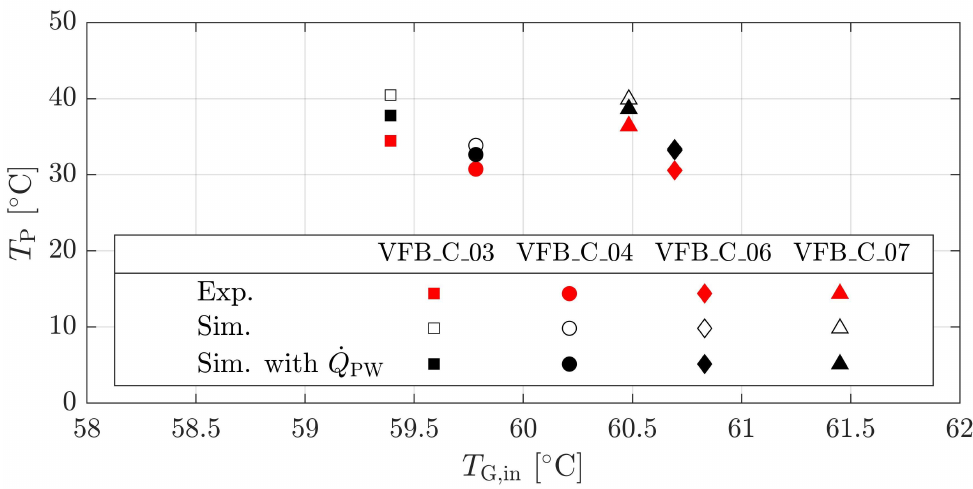
Figure 17. Influence of consideration of heat transfer between particles and dryer wall ( ˙ Q PW ) on predicted particle temperature ( T P ) against drying temperature ( T G,in ) for Cellets in the VFB dryer; compared to